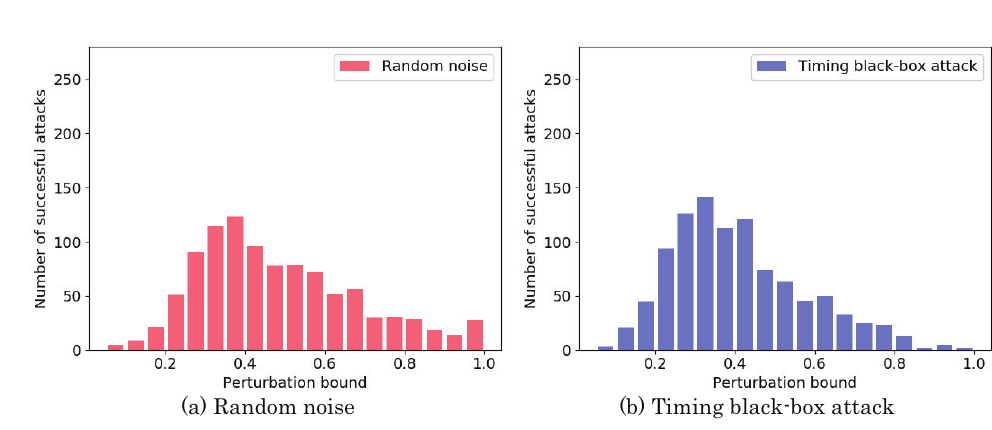
Figure 19: Histogram of successful attacks against Jetson nano GPU on 1,000 samples of MNIST dataset. Proposed attack is compared with random noise. Each perturbation bound is plotted when misclassification is caused by proposed attack and random noise.